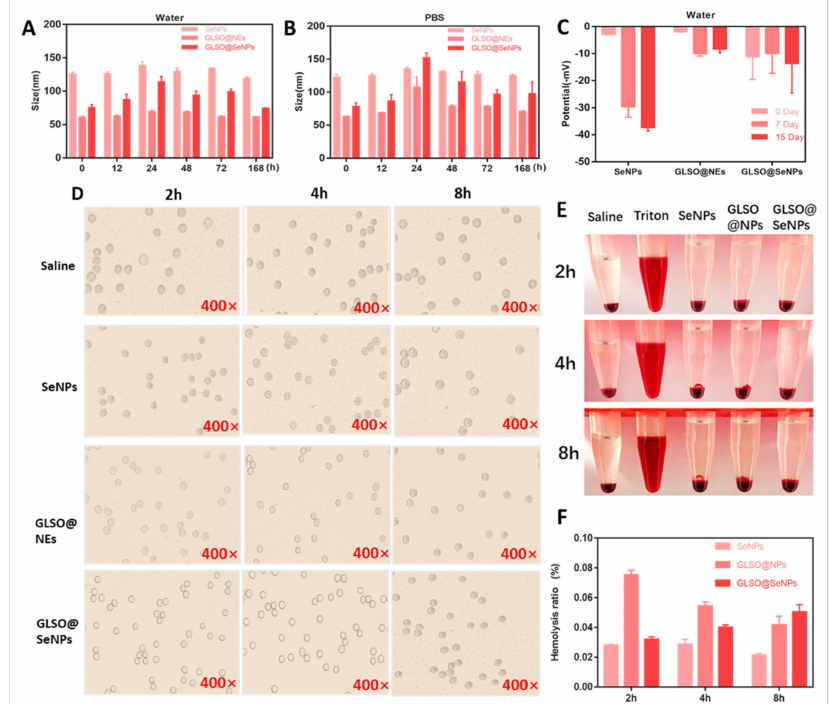
Figure 2. Stability assessment of SeNPs, GLSO@NEs, and GLSO@SeNPs. Changes in particle size